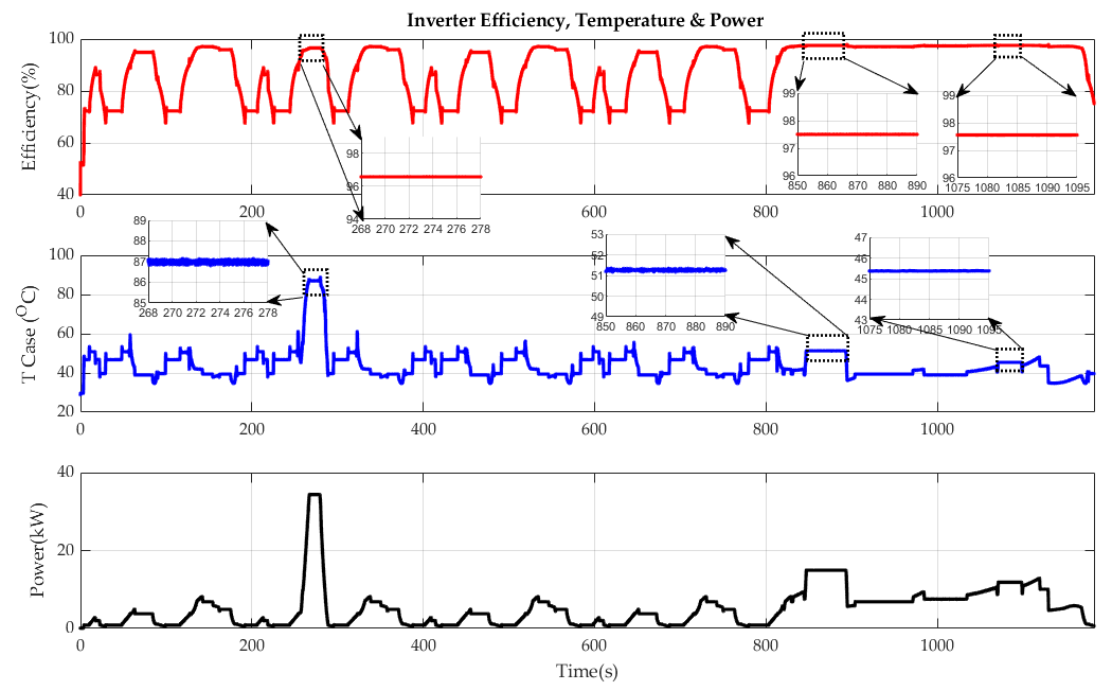
Figure 25. Inverter efficiency, case temperature, and power.